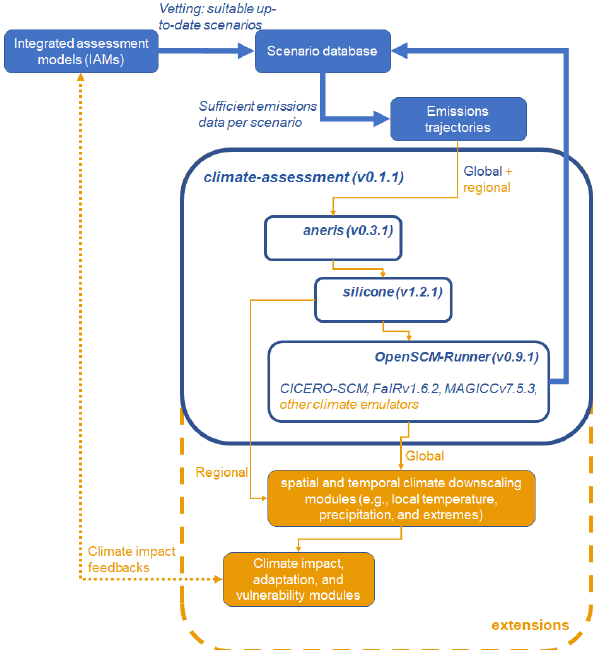
Figure 10. An overview of the current climate-assessment package (v0.1.1) and its workflow as applied for the IPCC AR6 mitigation scenarios climate, in blue. In orange are a few possible future ex- tensions of this community climate-assessment